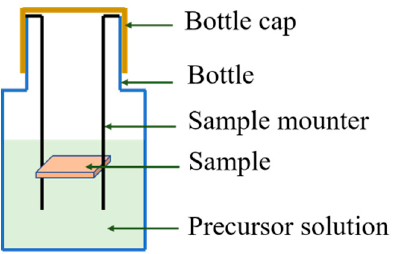
Figure 1. The scheme of the reactor.